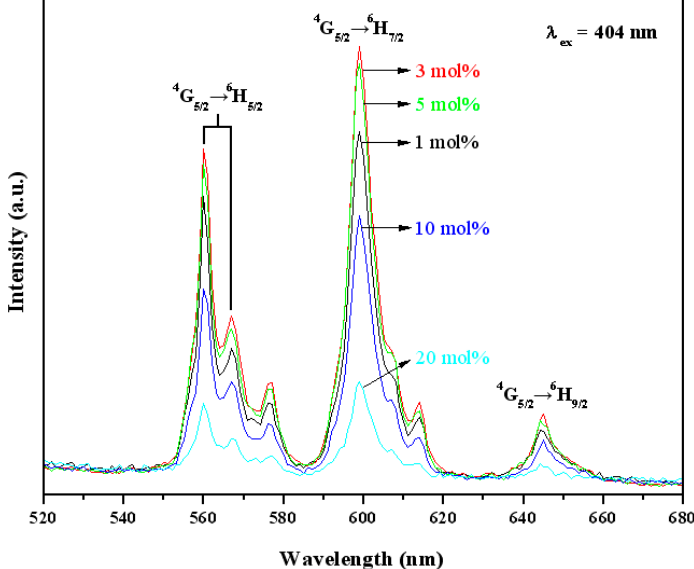
Figure 4. The emission spectra ( λ ex = 404 nm) of YInGe 2 O 7 doped with different concentration of Sm 3+ ions calcined at 1300 °C for 10 h in air.